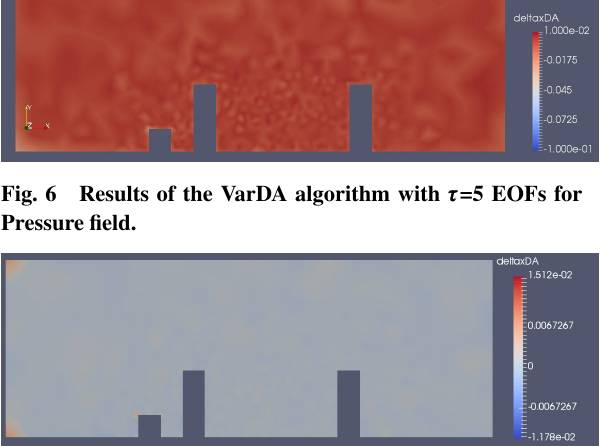
Fig. 4 Condition numbers of the reduced dimension matrices V (cid:28)(cid:28)(cid:28) obtained by EOFs for different values of (cid:27)(cid:27)(cid:27) (cid:28)(cid:28)(cid:28) .